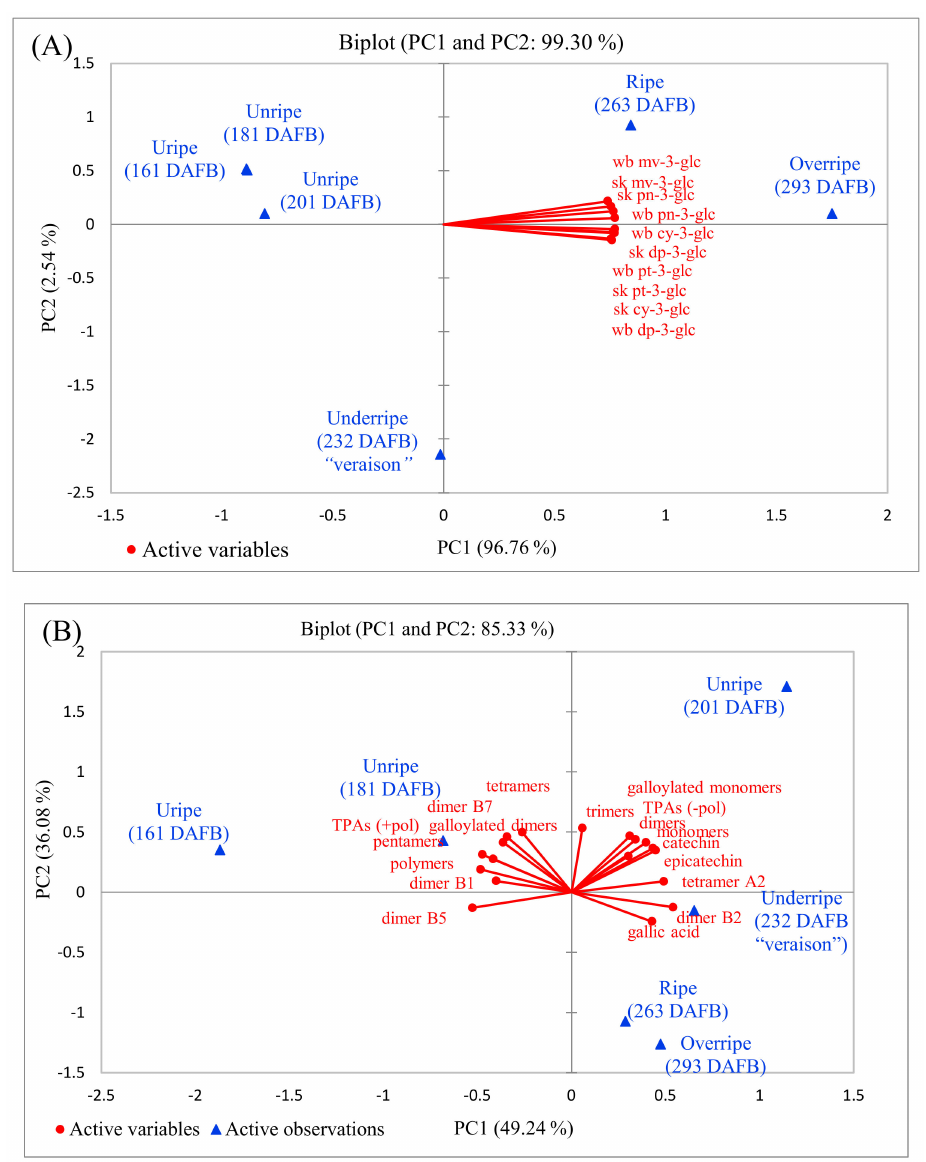
Figure 3. Biplot (PC1 × PC2) of scores and loadings for the PCA of all data of anthocyanins in skin and whole berry ( A ) and proanthocyanidins in seeds ( B ) of black ‘Isabel’ grape during six stages of development. Abbreviations: DAFB; days after full bloom, TPAs ( + pol); Total proanthocyanidin with polymers, TPAs ( − pol); Total proanthocyanidins without